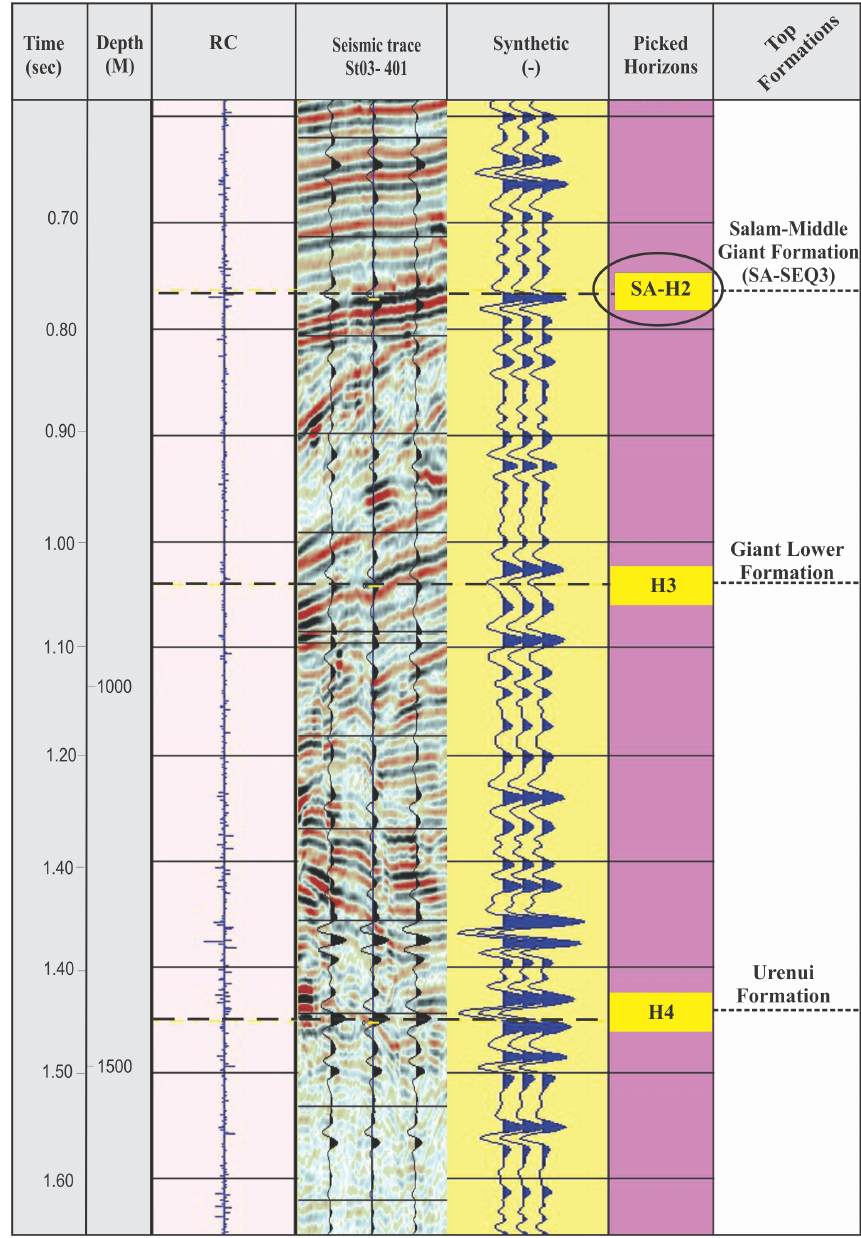
Figure 3. Generated synthetic seismograms that tied the well to the seismic